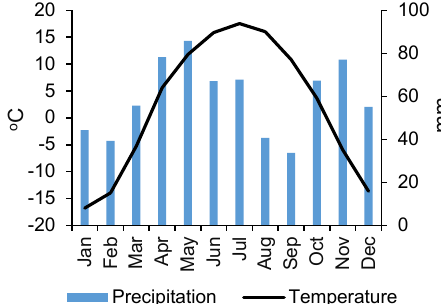
Figure 2. Temperature and precipitation climatology for the Lepsy meteorological station (45.32 ◦ N, 80.37 ◦ E; 1012ma.s.l.), 1960– 2014. Location of the station is shown in Fig.